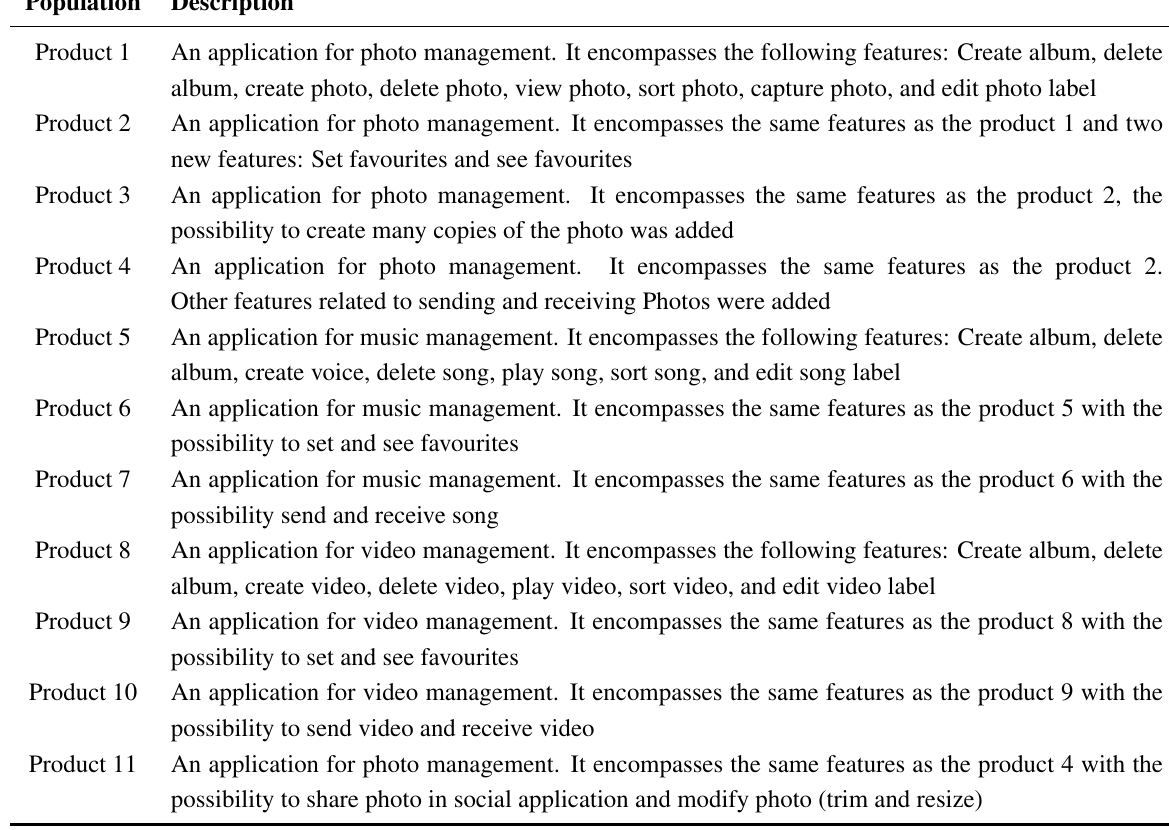
Table 1. Mobile Media SPL Population.